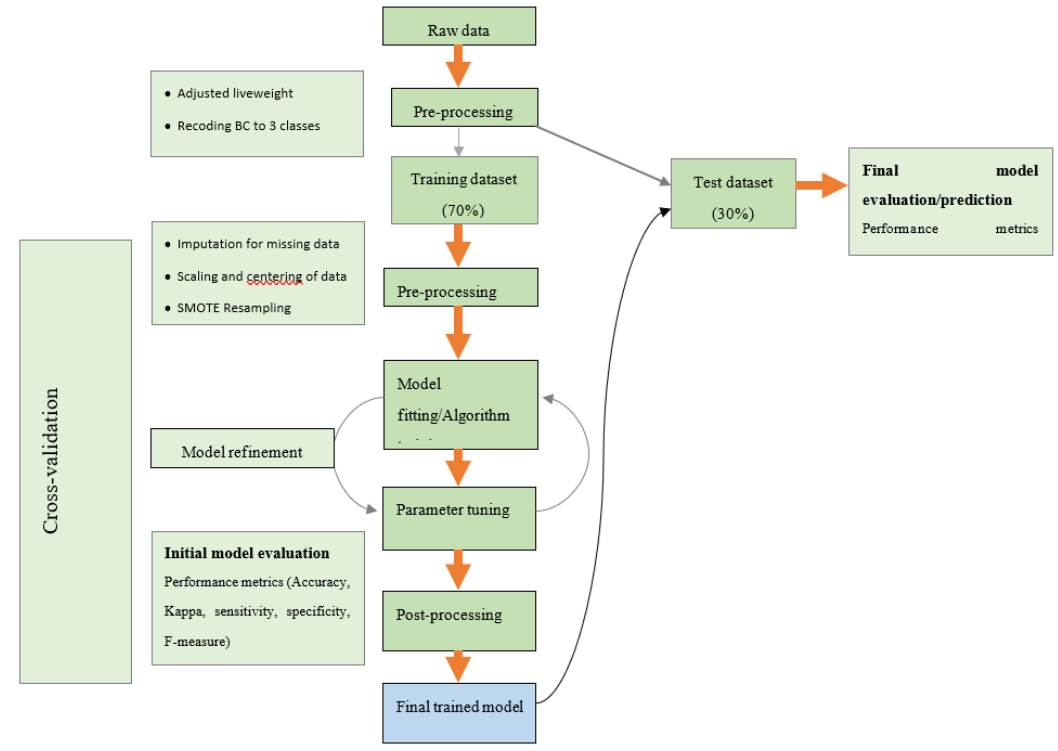
Figure A1. Machine learning flow chart for ewe BCS prediction using their current and previous liveweights.